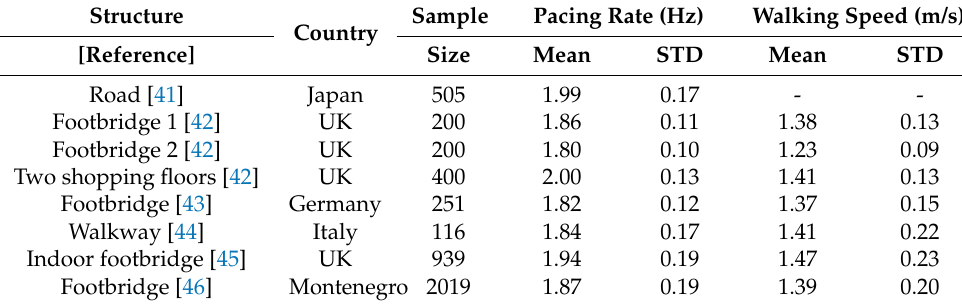
Figure 3. ( a ) Data points for DLF 1 versus pacing frequency. Solid black line—best data fit. Red solid lines—best fit ± 2 standard deviations. ( b ) Data points for DLF 2 versus pacing frequency. Solid black line—mean value. (after Kerr [38]). Table 1. Statistics of pacing rate and walking speed on a range of